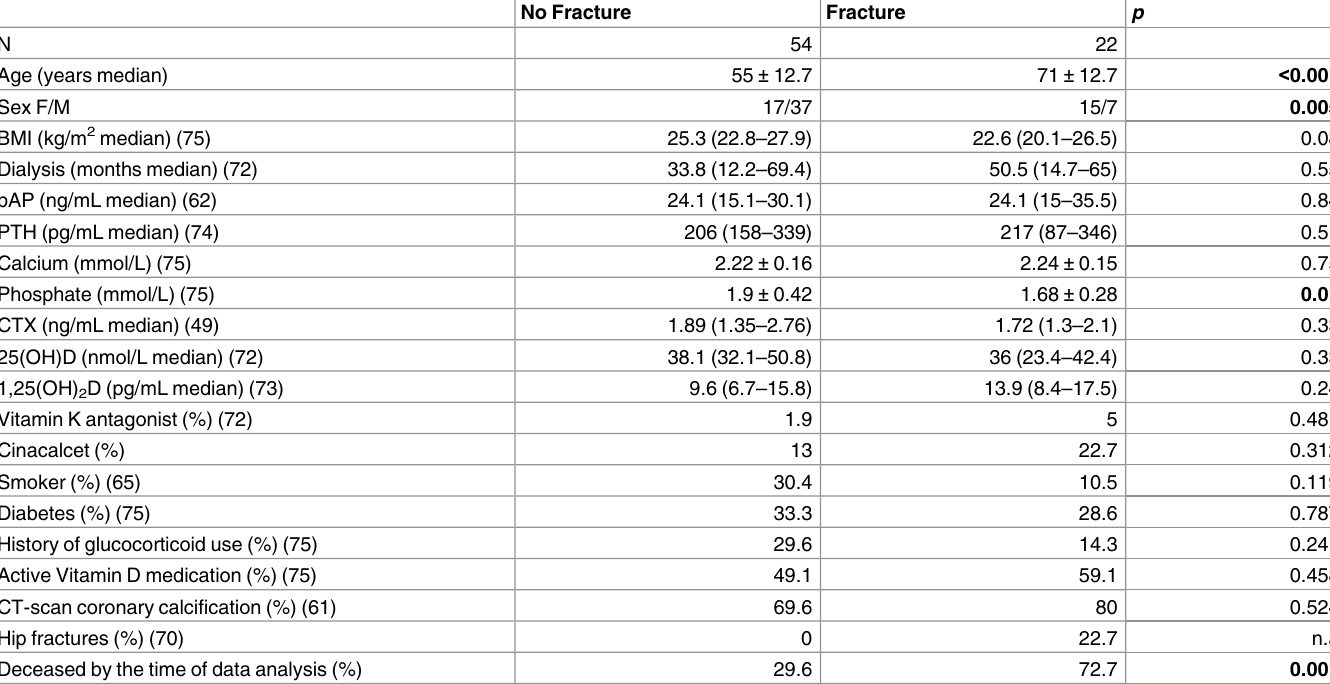
Table 1. Patient demographic